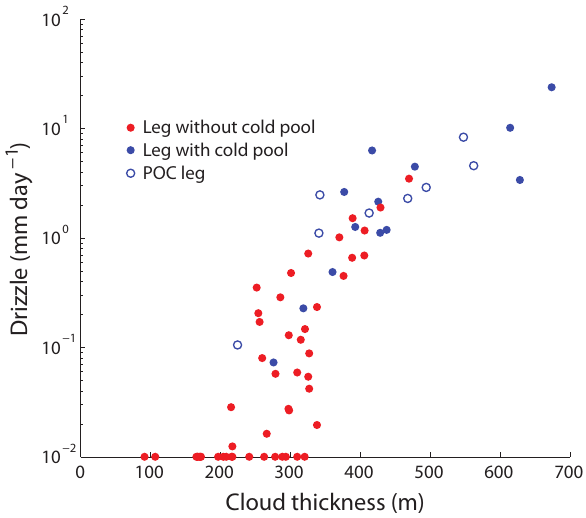
Fig. 8. Leg-mean PCASP aerosol concentrations are plotted against the leg-mean cloud top heights obtained from the WCR for legs with (blue) and without (red) cold pools. Open circle indicate legs located in pockets of open cells, all of which had cold